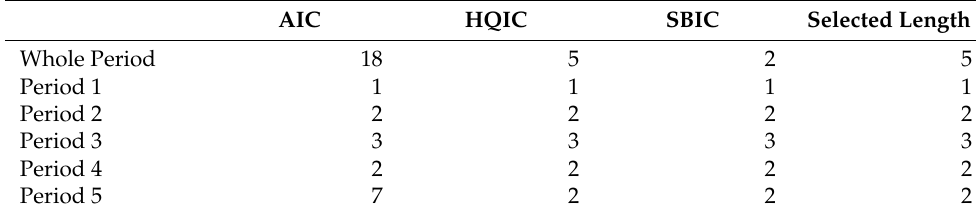
Table 4. Optimal lag length by AIC, HQIC, and SBIC.